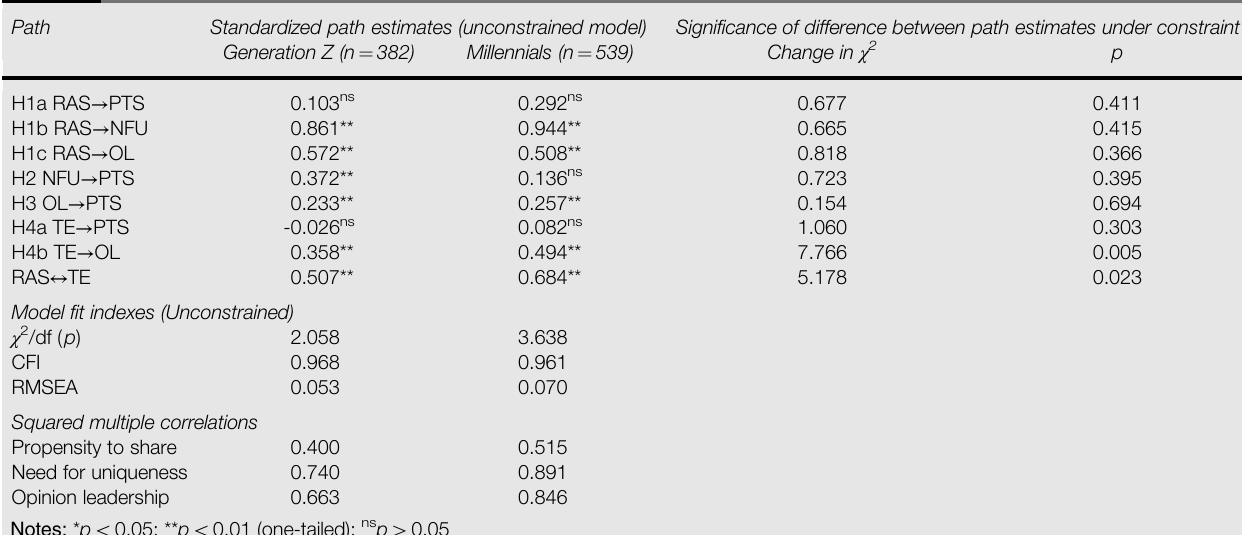
Path Standardized path estimates (unconstrained